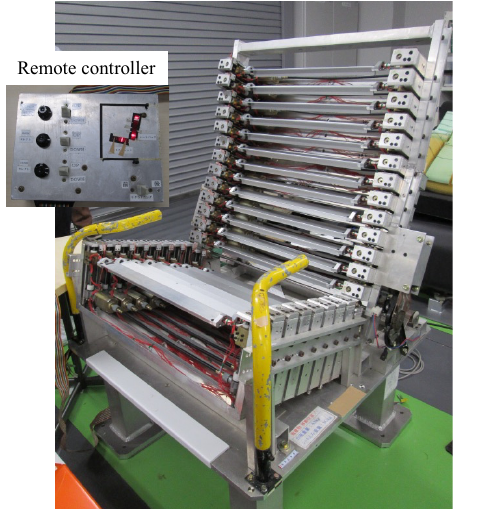
Figure 9. Experimental seat. The sensitivity distribution of five participants is shown in Figure 10.